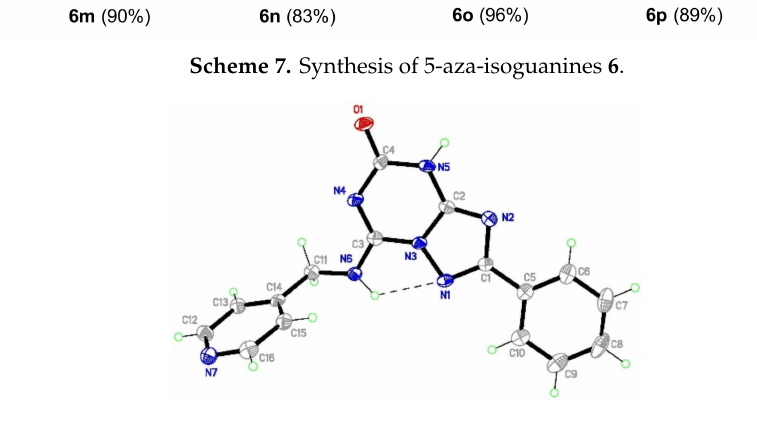
Figure 2. X-ray structure of 6l